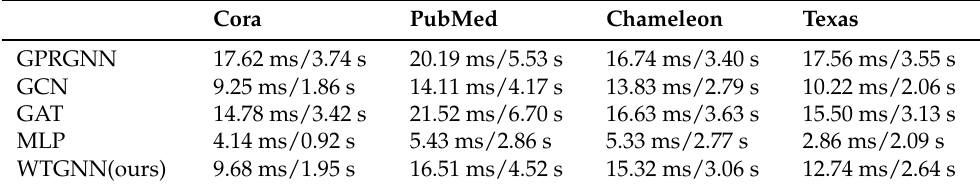
Table 2. Efficiency on selected real-world benchmark